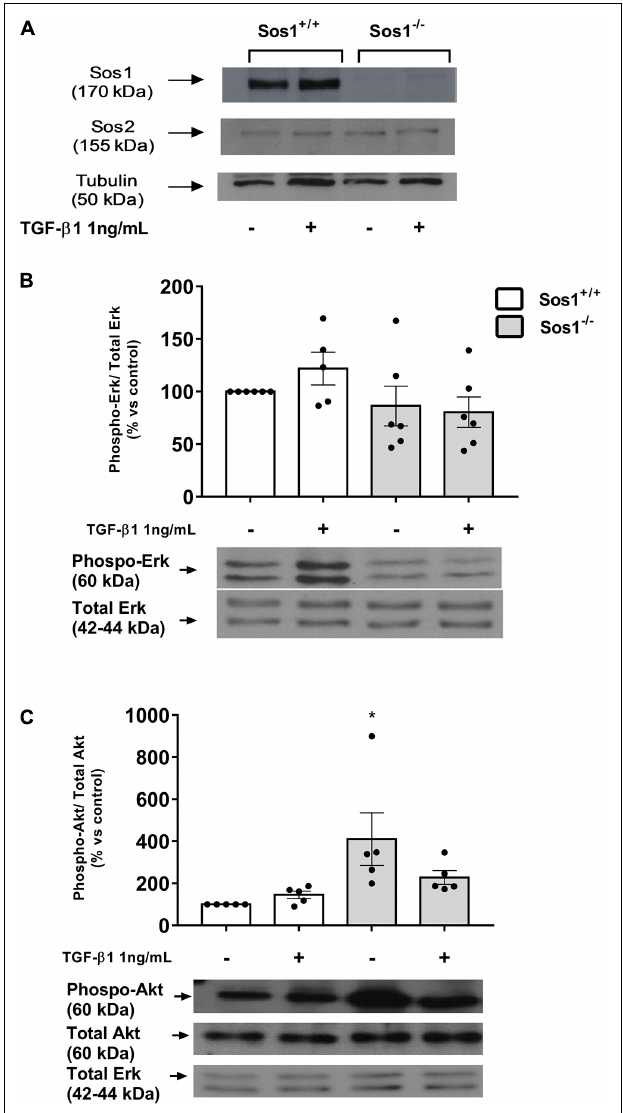
FIGURE 1 | Effect of Sos-1 deficiency on phospho-Erk and phospho-Akt expression in fibroblasts. Sos-1 and Sos-2 expression evaluated by western blot (A) ; phospho-Erk and total Erk (B) , and phospho-Akt and total Akt (C) protein expression evaluated by western-blot 24 h after depletion and after TGF- β 1 treatment (1 ng/mL, 24 h). Lower panel in panels (B,C) shows a representative blot of 5-6 experiments. Histograms in panels (B,C) represent the mean ± S.E.M. of the optical density of the bands of 5 experiments, expressed as percentage over basal values (Sos-1 + / + fibroblasts in basal conditions, 100%). Histograms correspond to the ratio phospho-Erk 1/2/Erk 1/2 or phospho-Akt/Akt/Erk 1/2 (Erk 1/2 used as loading control). Statistically significant differences: * p < 0,05 vs. Sos1 + / + fibroblasts in basal